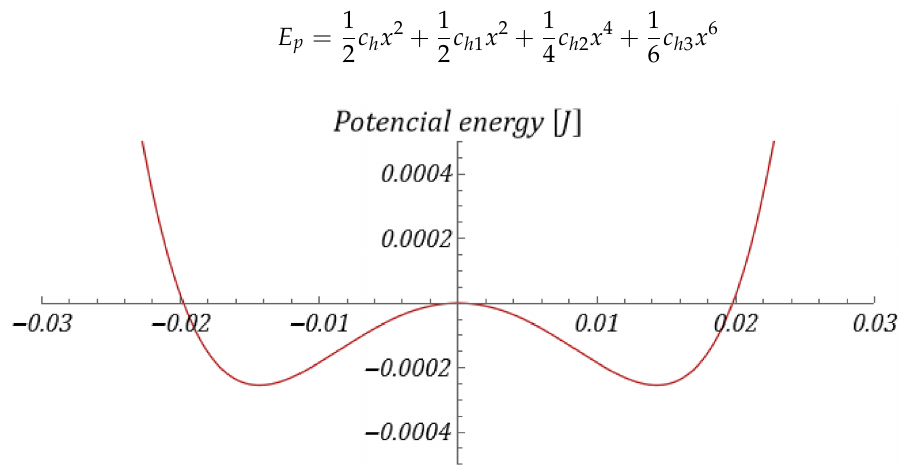
Figure 7. Potential energy functions of M-EHS for a specified magnet